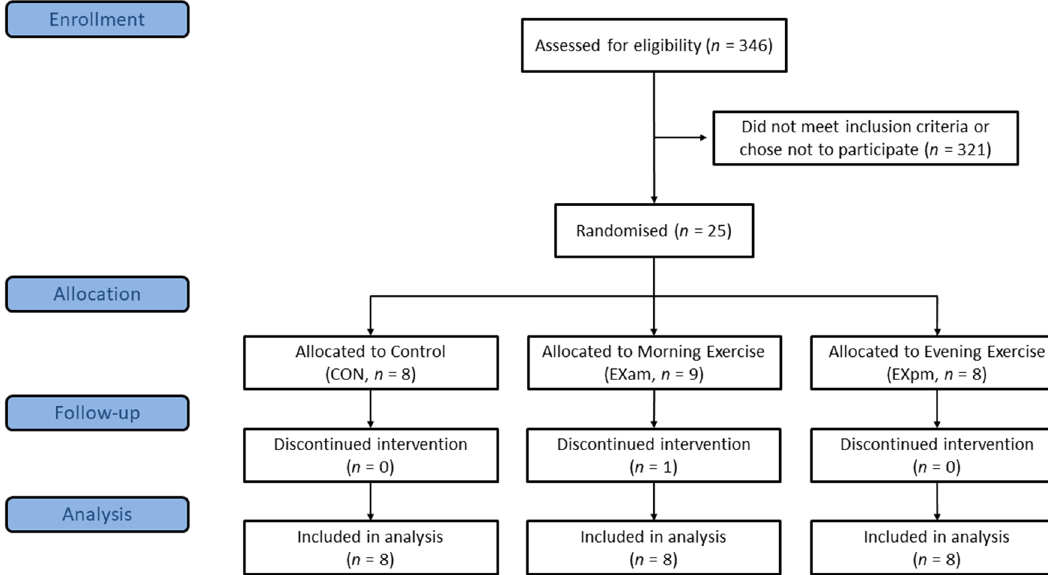
Figure 1. Flowchart of participants.